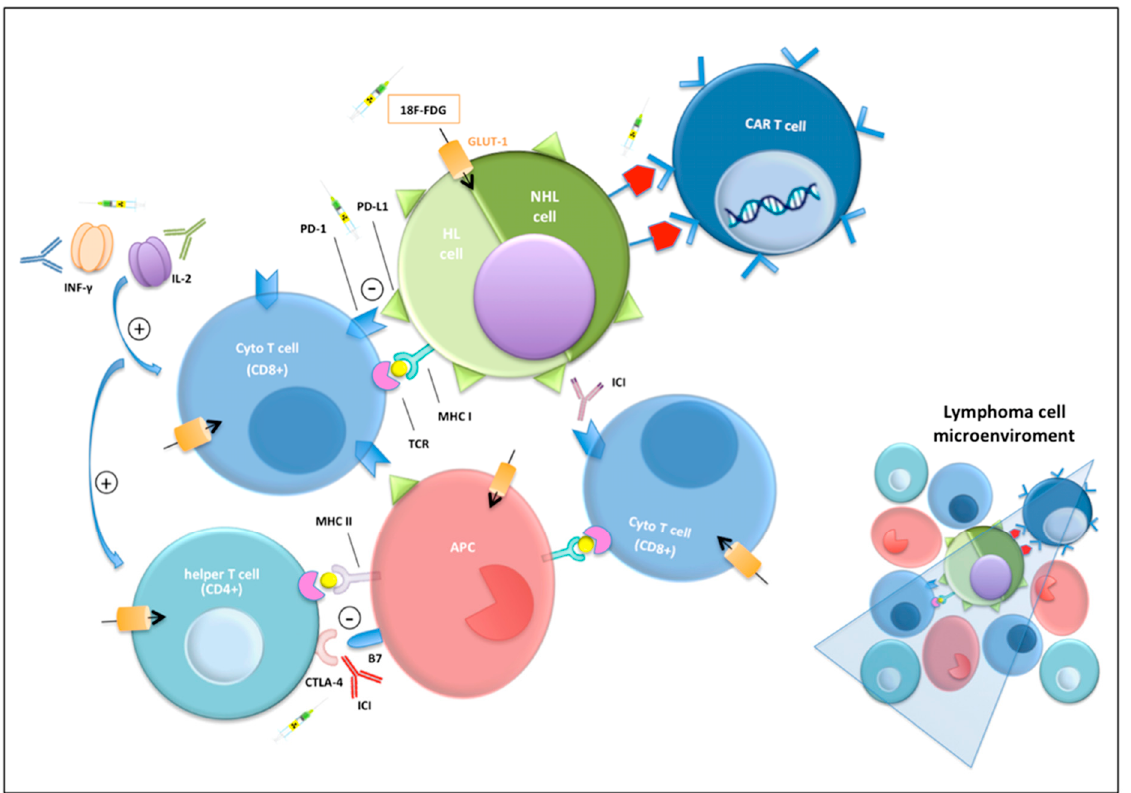
Figure 1. Schematic representation of immunological mechanism in Hodgkin (HL) and Non Hodgkin (NHL) lymphoma microenvironment, focusing on immunotherapy and PET imaging targets. Chimeric antigen receptor T-cell (CAR-T); glucose transporter 1 (GLUT1); programmed cell death protein-1 (PD-1); programmed cell death protein-ligand 1 (PD-L1); T-cell receptor (TCR); antigen-presenting cell (APC); cytotoxic T-lymphocyte antigen 4 (CTLA-4); interferon (IFN), interleukin-2 (IL2); immune-checkpoint inhibitor (ICI); major histocompatibility complex (MHC).